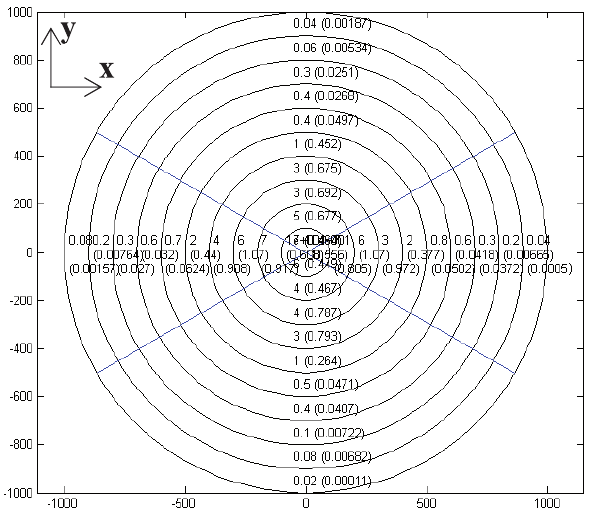
Fig. 7. Arriving fragment probability and their energy per sector. (The number between brackets represent energies in [MJ], the others correspond to the arriving projectile proba-